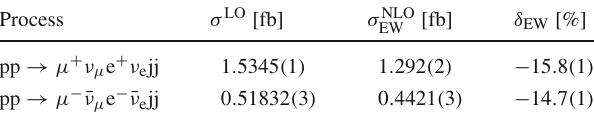
Table 1 Cross sections at LO [ O relative EW corrections are given in per cent, and the digits in paren- thesis indicate the integration error